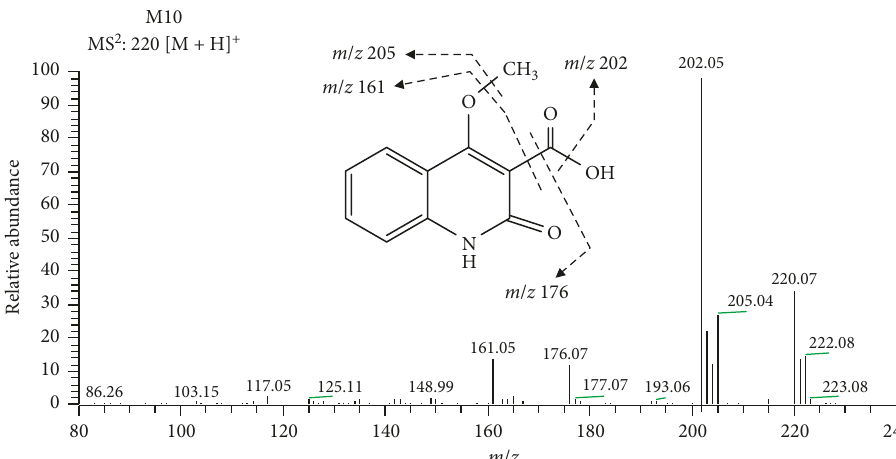
Figure 3: The proposed fragmental pathway and the MS 2 bar graph of